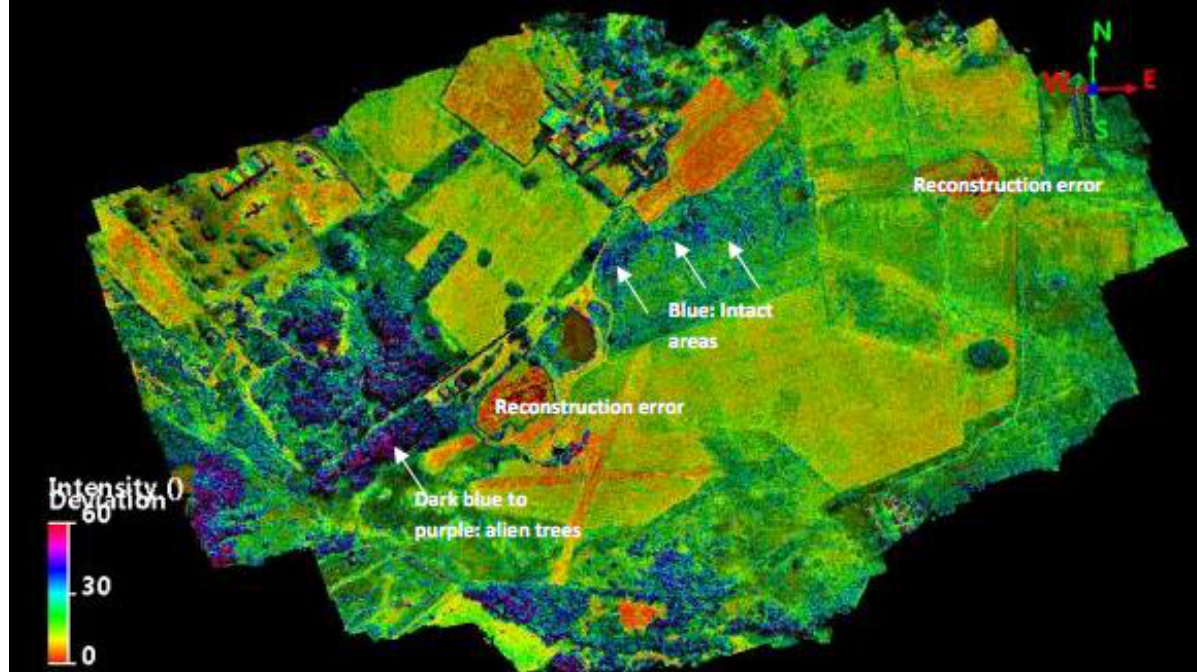
Figure 3. Intensity deviation calculation from DPC to identify and estimate the disturbance classes